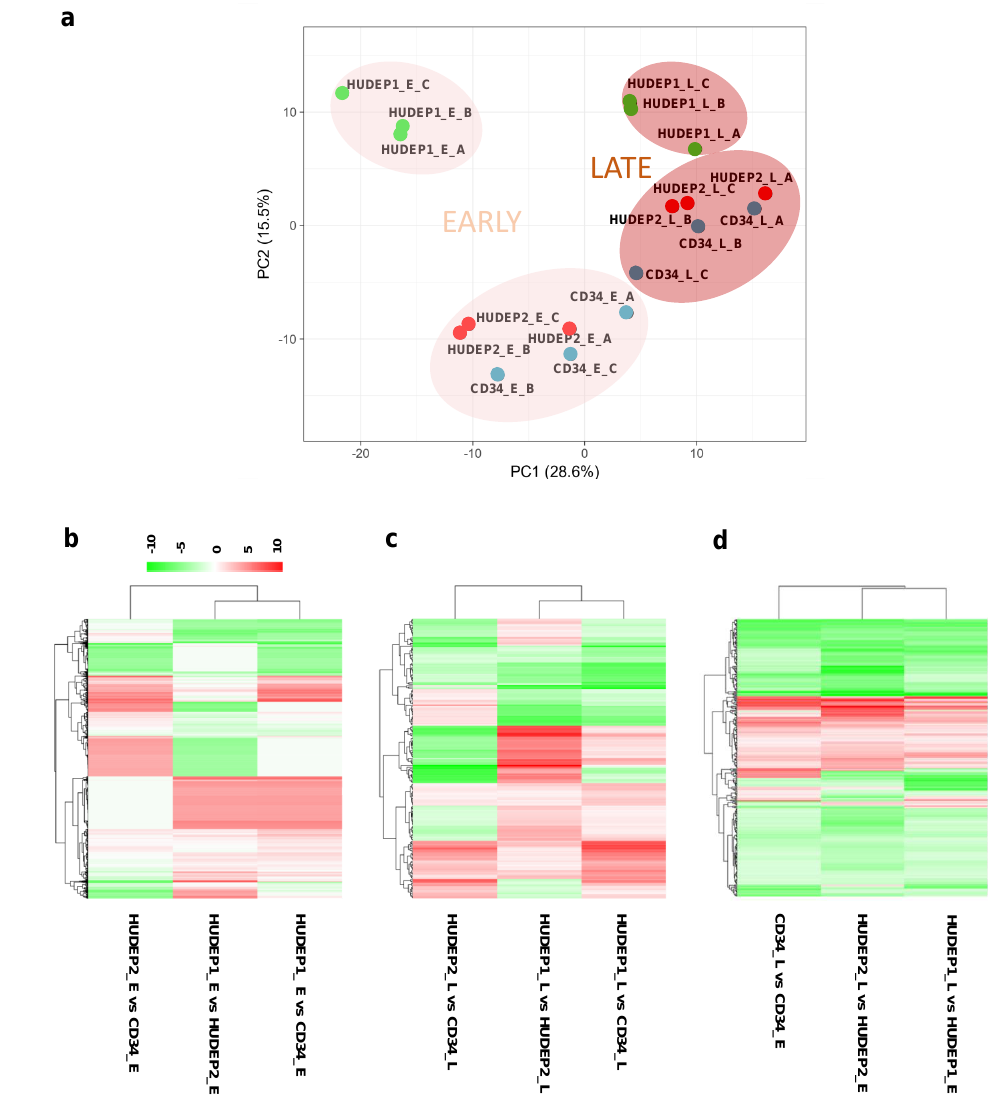
Figure 3. Comparative analysis of miRNA expression in primary hCD34+ and HUDEP cells dur- ing erythroid differentiation. ( a ) Principal component (PC) analysis of known and novel miRNA expression. Clustering of samples by differentiation stage is denoted by colors (pale pink: early, dark pink: late). ( b , c ) Hierarchical clustering of all known and novel, consistently differentially expressed (DE) miRNAs for early-stage ( b ) and late-stage ( c ) comparisons between cell types. ( d ) Hierarchical clustering of all known and novel, consistently DE miRNAs for erythroid differentiation (_L vs. _E) of all three cell types. For ( b – d ), the X-axis represents pairwise comparisons and the Y-axis represents DE miRNAs; for ( d ), the child node was rotated post-analysis to place HUDEP-2 cells in the center of the heat map. The colors indicate the fold change, with red showing upregulation, and green showing